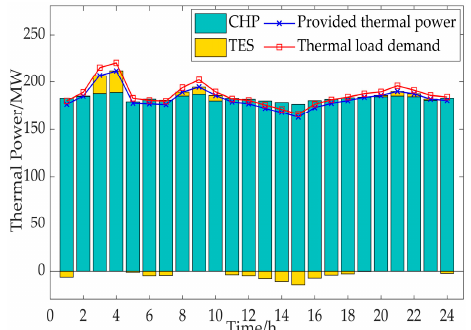
Figure 10. Heat power dispatch results of combined heat and power (CHP) and thermal energy storage (TES). Table 3. Optimized costs of dispatch model I and dispatch model II.